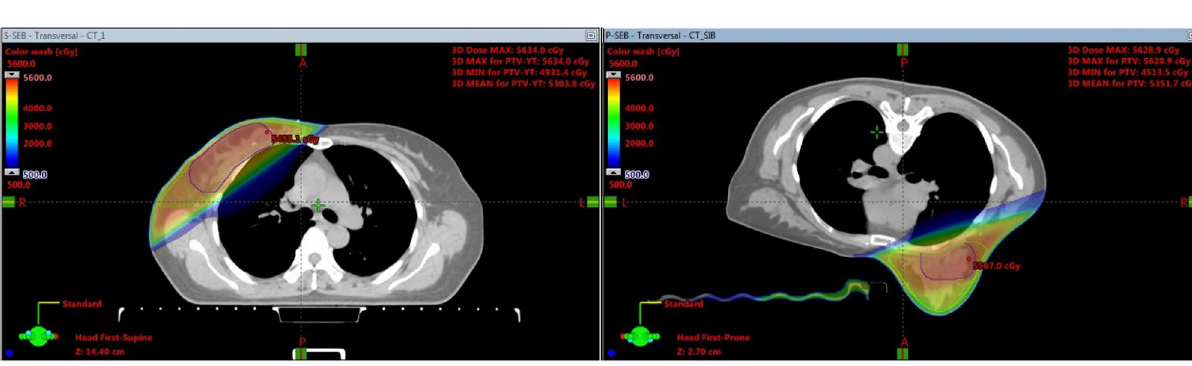
Figure 2. The picture of target volumes and isodose distribution based on supine and prone position for SEB-